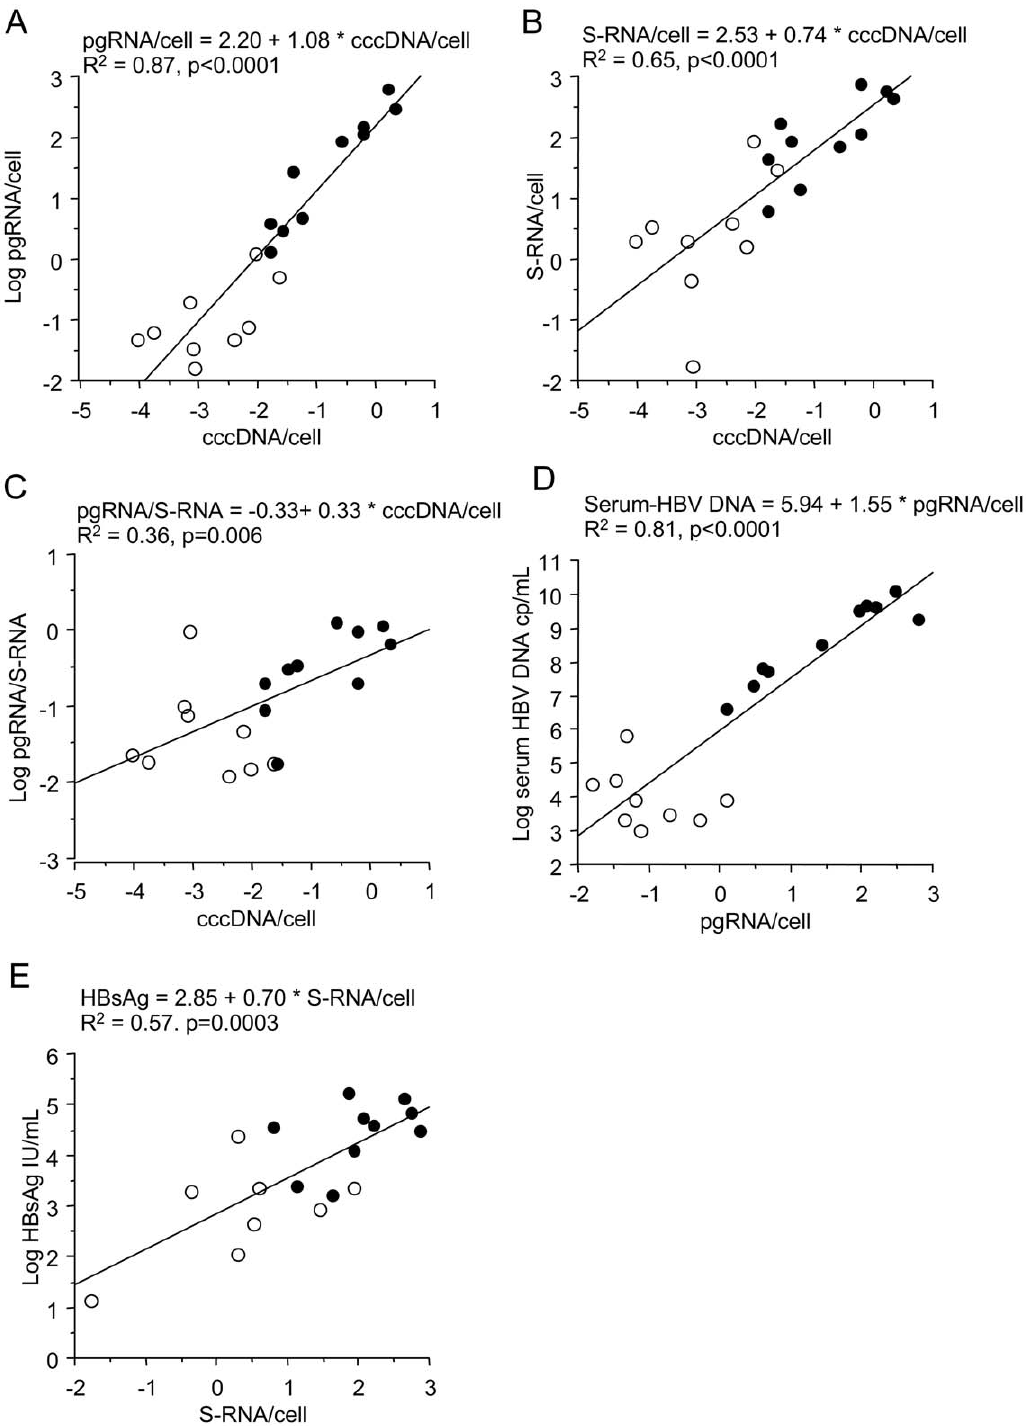
Figure 2. Correlations between different markers for viral productivity in liver and serum. A-C show strong correlation in 19 liver biopsies between cccDNA levels and pgRNA (A) and S-RNA (B), and significant correlation between cccDNA and pgRNA/S-RNA ratio (C). D shows strong correlation between pgRNA and serum levels of HBV DNA (but lack of correlation within the HBeAg-negative subgroup). E shows relatively strong correlation between S-RNA and HBsAg in serum. Filled dots HBeAg positive, open dots HBeAg negative. doi:10.1371/journal.pone.0036349.g002 example antiviral resistance, but this approach might not be in transfected cells and liver biopsies, and observed that the accurate for evaluating the effects on replication by escape pgRNA/cccDNA ratio was approximately 1 log lower in mutations. To assess this we compared transcription efficiencies transfected Huh7.5 cells than in the liver tissue. This lower